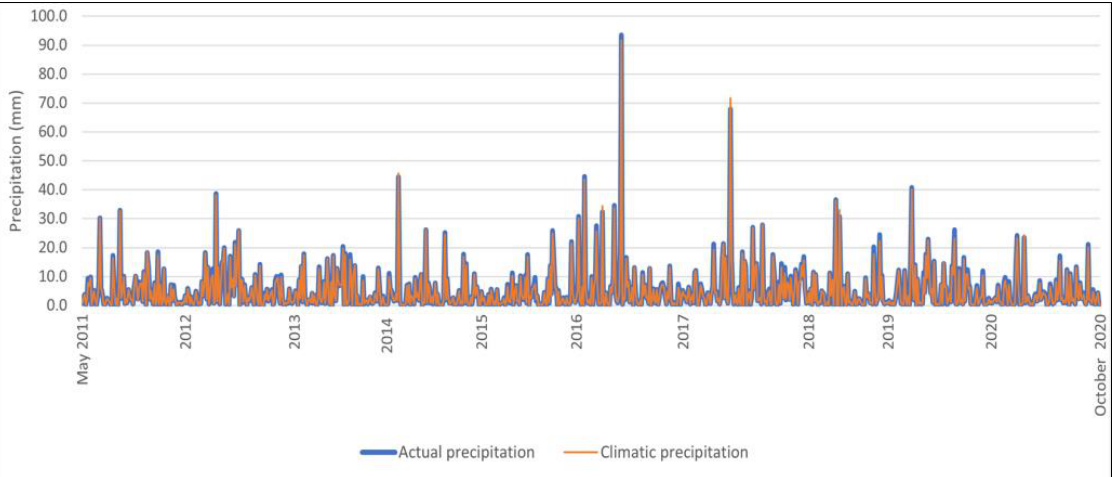
Figure 4. Daily actual precipitation and climatic precipitation from May to October in the period from 2011 to 2020.